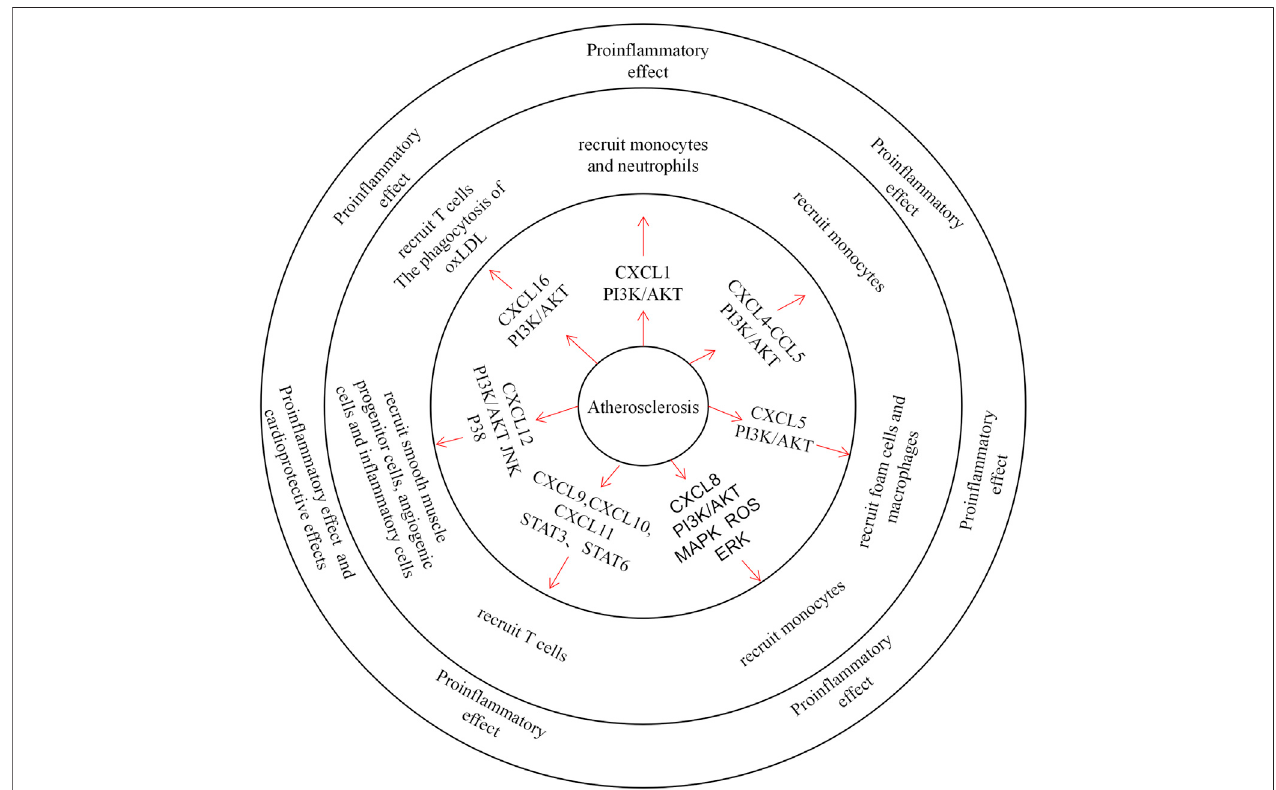
FIGURE1| TheroleofCXCChemokinesinatherosclerosis.Chemokinesmainlycontrolthemigrationofneutrophils,monocytes,Tcells,smoothmuscleprogenitor cells and angiogenic cells in atherosclerosis. CXCL1 and CXCL8 recruit neutrophils through the PI3K / AKT pathway and plays a pro-in fl ammatory role. CXCL4 forms heterodimers with CCL5 to recruit monocytes. CXCL9, CXCL10 and CXCL11 recruit T cells through STAT3, STAT6 pathway, exacerbating tissue in fl ammation. And CXCL12recruitssmoothmuscleprogenitorcells,angiogeniccellsandin fl ammatorycells,whichalsoplaysapro-in fl ammatoryroleandaprotectiverole.Inaddition, CXCL16 recruits T cells and acts as an oxLDL clearance